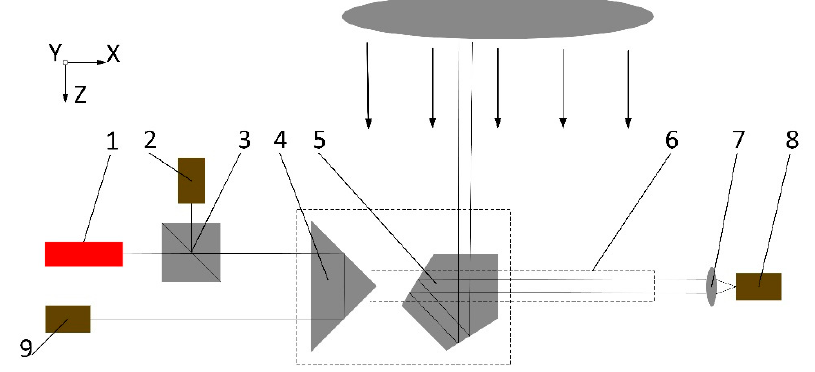
Figure 2. Real-time compensation schematic diagram. 1, laser; 2, 8, 9, CCD cameras; 3, beam-splitting prism; 4, right-angle prism; 5, pentaprism; 6, guide rail; 7, lens.